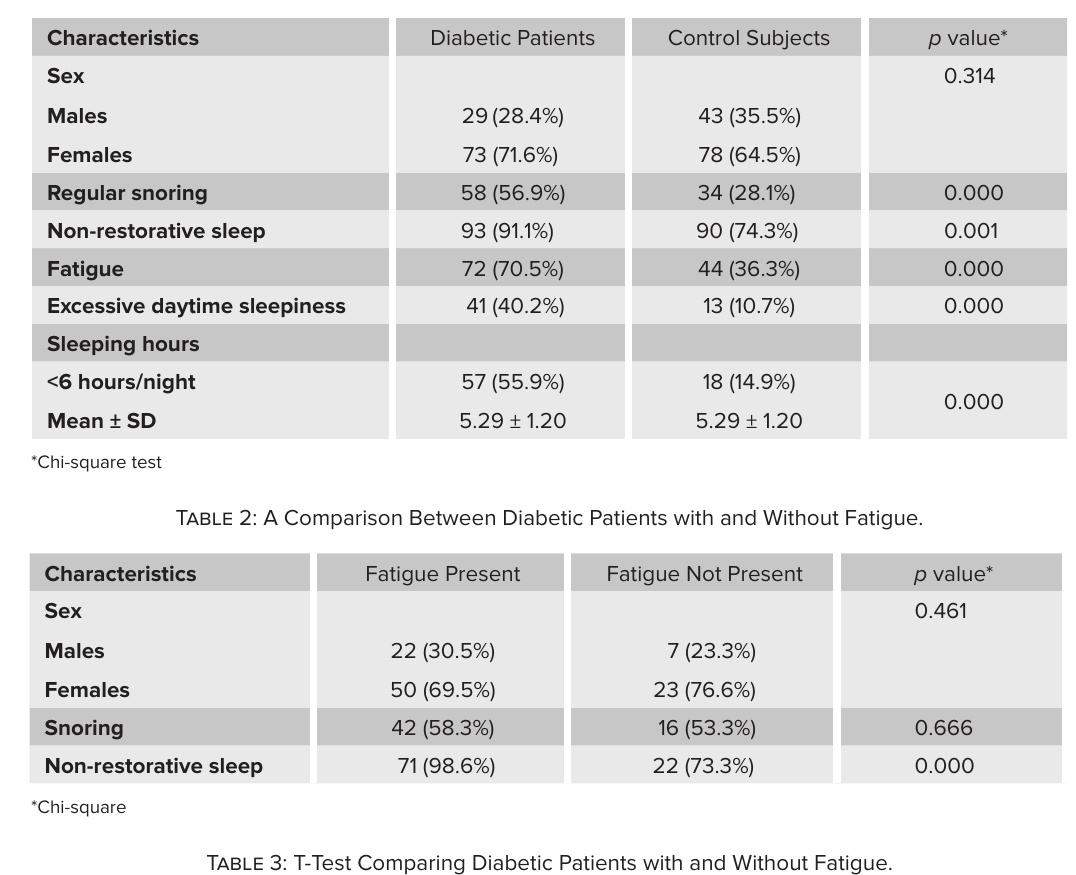
Table 1: Comparison Between Patients with Type 2 Diabetes and Control Subjects.